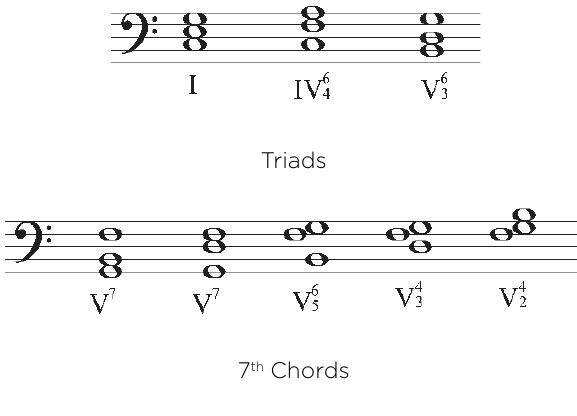
FIGURE 7 | Chords